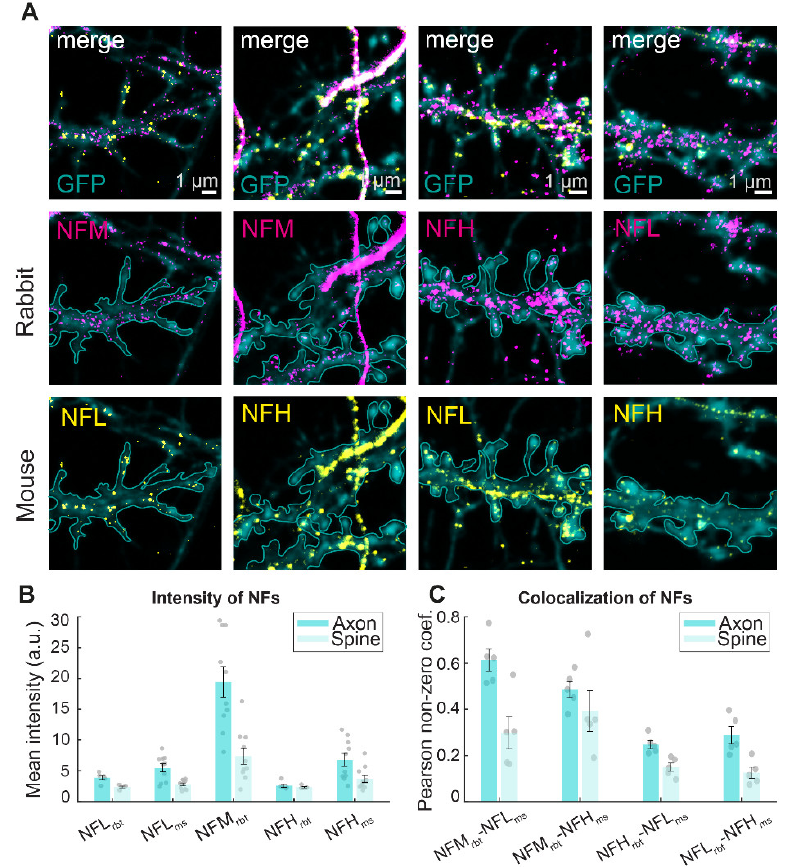
Figure 1. Distribution of NF signal in different neuronal compartments. ( A ) Representative STED images of NF isoforms (magenta for rabbit (rbt) and yellow for mouse (ms)) and confocal GFP volume labeling (cyan) in primary hippocampal neurons. Corresponding large fields of view images can be found in Figure S1. Cyan outline represents spine shapes on dendrites as determined by volume labeling. Scale bars are 1 µ m. ( B ) Mean fluorescence intensity of the NF isoforms in axons and dendritic spines. ( C ) Colocalization analysis of NFs in axons and dendrites. Shown is the mean values of Pearson’s correlation coefficient of all pixels with non-zero intensities. Er- ror bars show the standard error of the mean (SEM), points represent average values of individ- ual images. Intensities and colocalization data calculated from 5 images per antibody pair from one neuronal culture (21–26 DIV). Number of spines: NFM rbt -NFL ms = 171; NFM rbt -NFH ms = 63; NFH rbt -NFL ms = 148; NFL rbt -NFH ms =